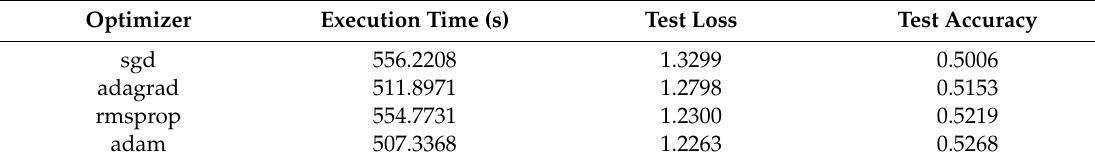
Table 15. E ff ect of adaptive learning rate on